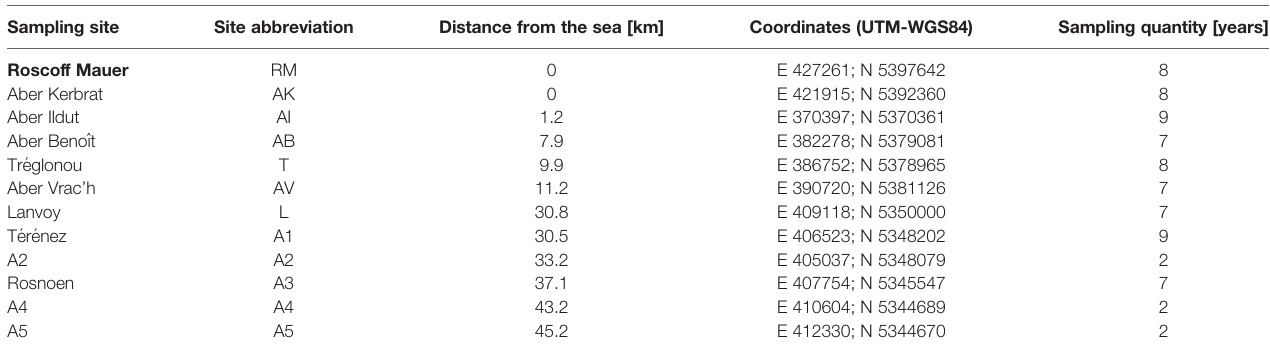
TABLE 1 | Sampling sites in north-west Brittany, indicating site abbreviations, distance from the sea, coordinates and number of samples taken. Sampling